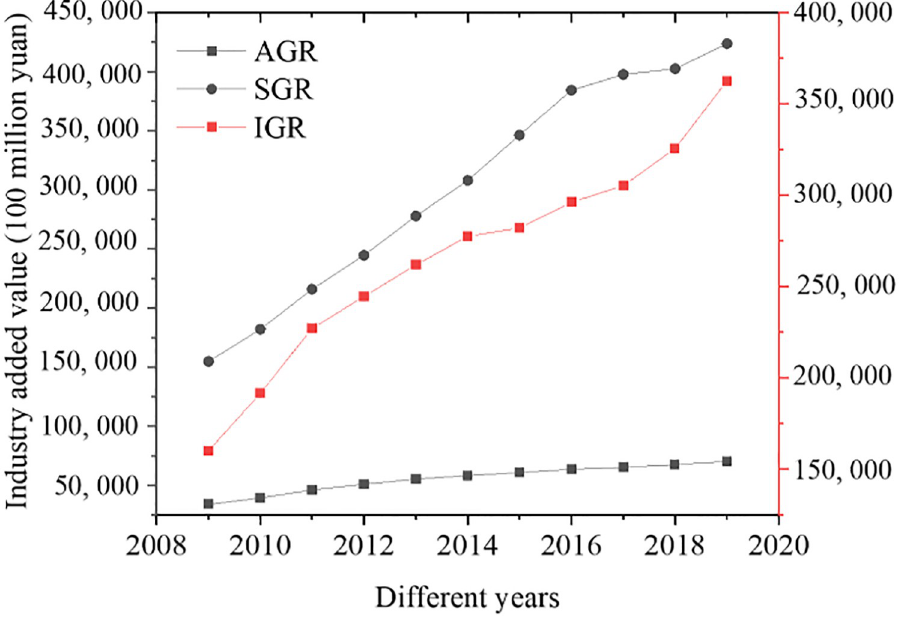
Fig 2. The proportion of the three industries changing over